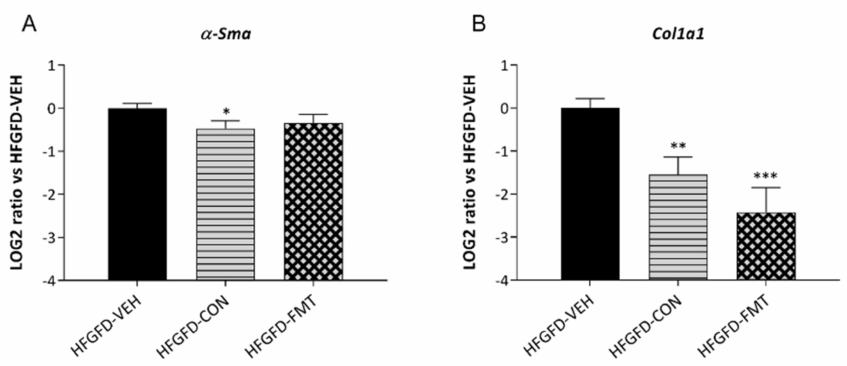
Figure 2. Relative mRNA expression of ( A ) α -Sma and ( B ) Col1a1 measured by quantitative RT-PCR in the liver of NASH rats and expressed as log2 ratio. β -Actin was used as an endogenous control, and results were normalized to the HFGFD-VEH group. HFGFD-VEH: group of NASH rats receiving sham gavage (vehicle); HFGFD-CON: group of NASH rats receiving the 9-strain bacterial consortium daily; HFGFD-FMT: group of NASH rats receiving fecal microbiota transplantation from control lean rats (1 × transplantation followed by sham gavage). Abbreviations: α -Sma, alpha-Smooth muscle actin; Col1a1, Collagen type I alpha 1 chain. *, **, *** p ≤ 0.05, ≤ 0.01, and ≤ 0.001, respectively, versus